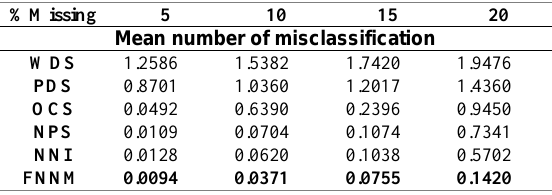
Table 3. Mean prototype error on the artificial data set.